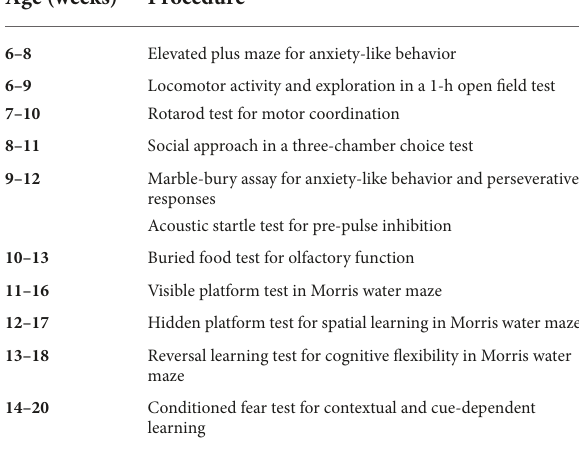
TABLE 2 Experimental timeline of general behavioral